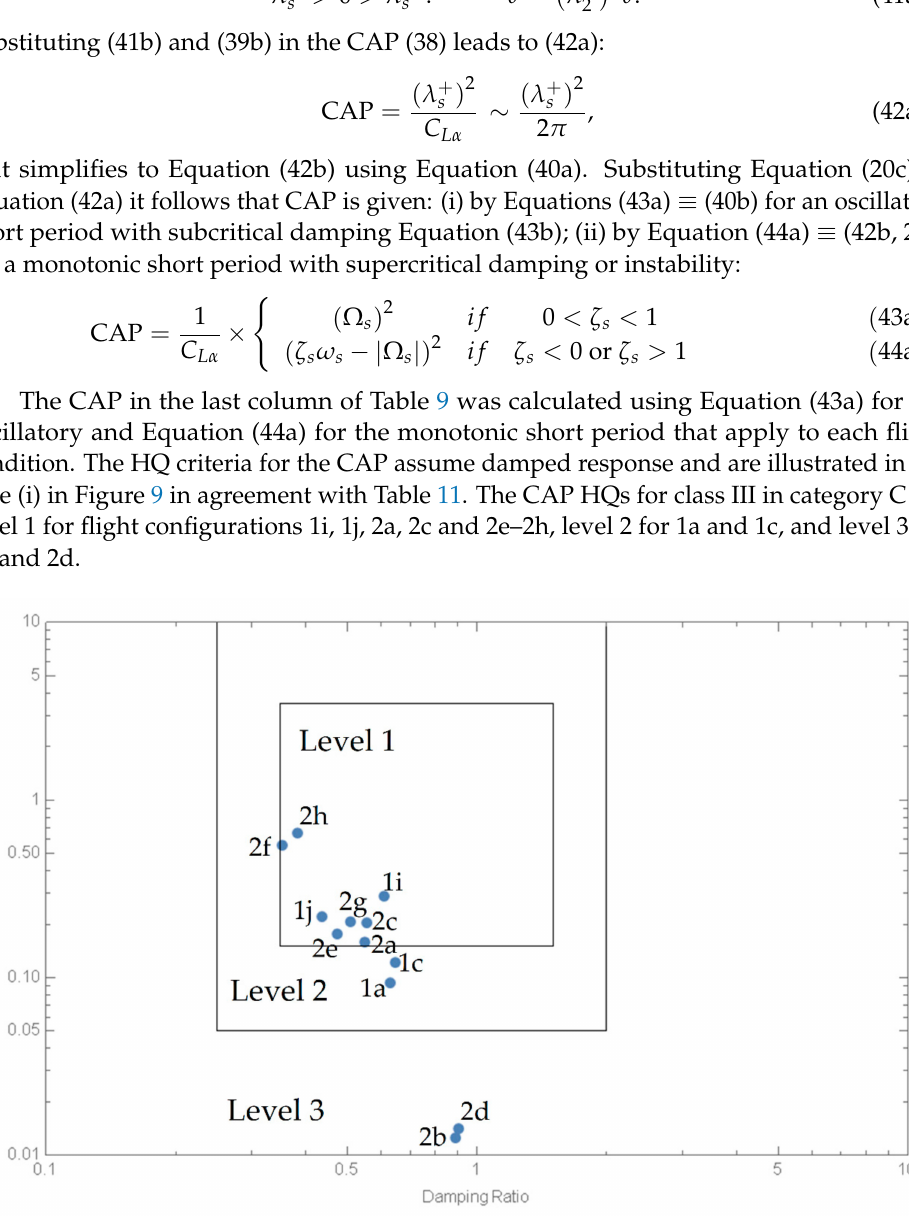
Figure 9. CAP boundaries for class III Cat C flight